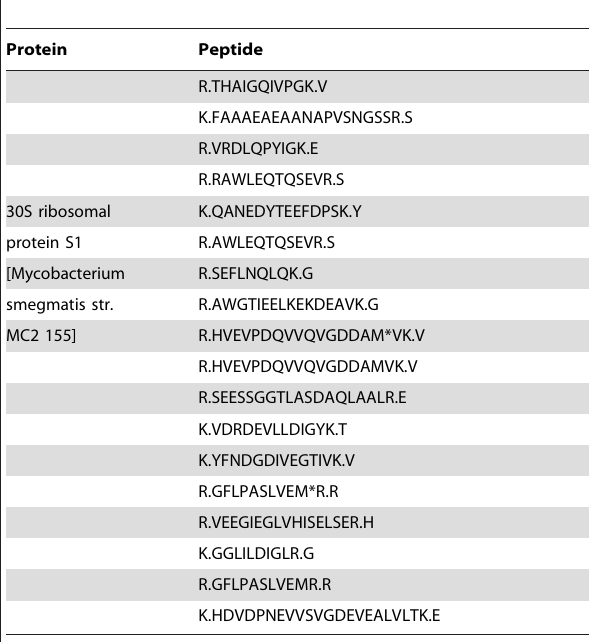
Table 1. Peptides of ribosomal protein S1 identified by mass